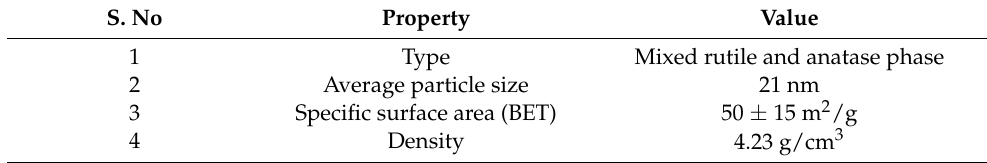
Table 3. Titanium dioxide properties.